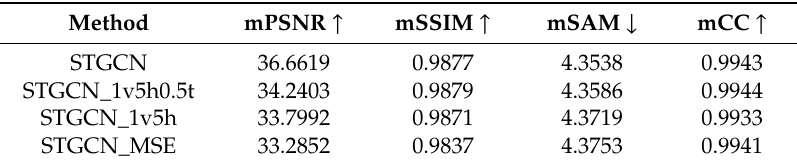
Table 6. Quantitative evaluation of cloud removal algorithms with di ff erent components of loss functions on data I. STGCN_1v5h0.5t means the loss function is the weighted addition of mean square error (MSE) for clear pixels with weight 1, damaged pixels with weight 5, and TV loss with weight 0.5, without the perceptual loss.